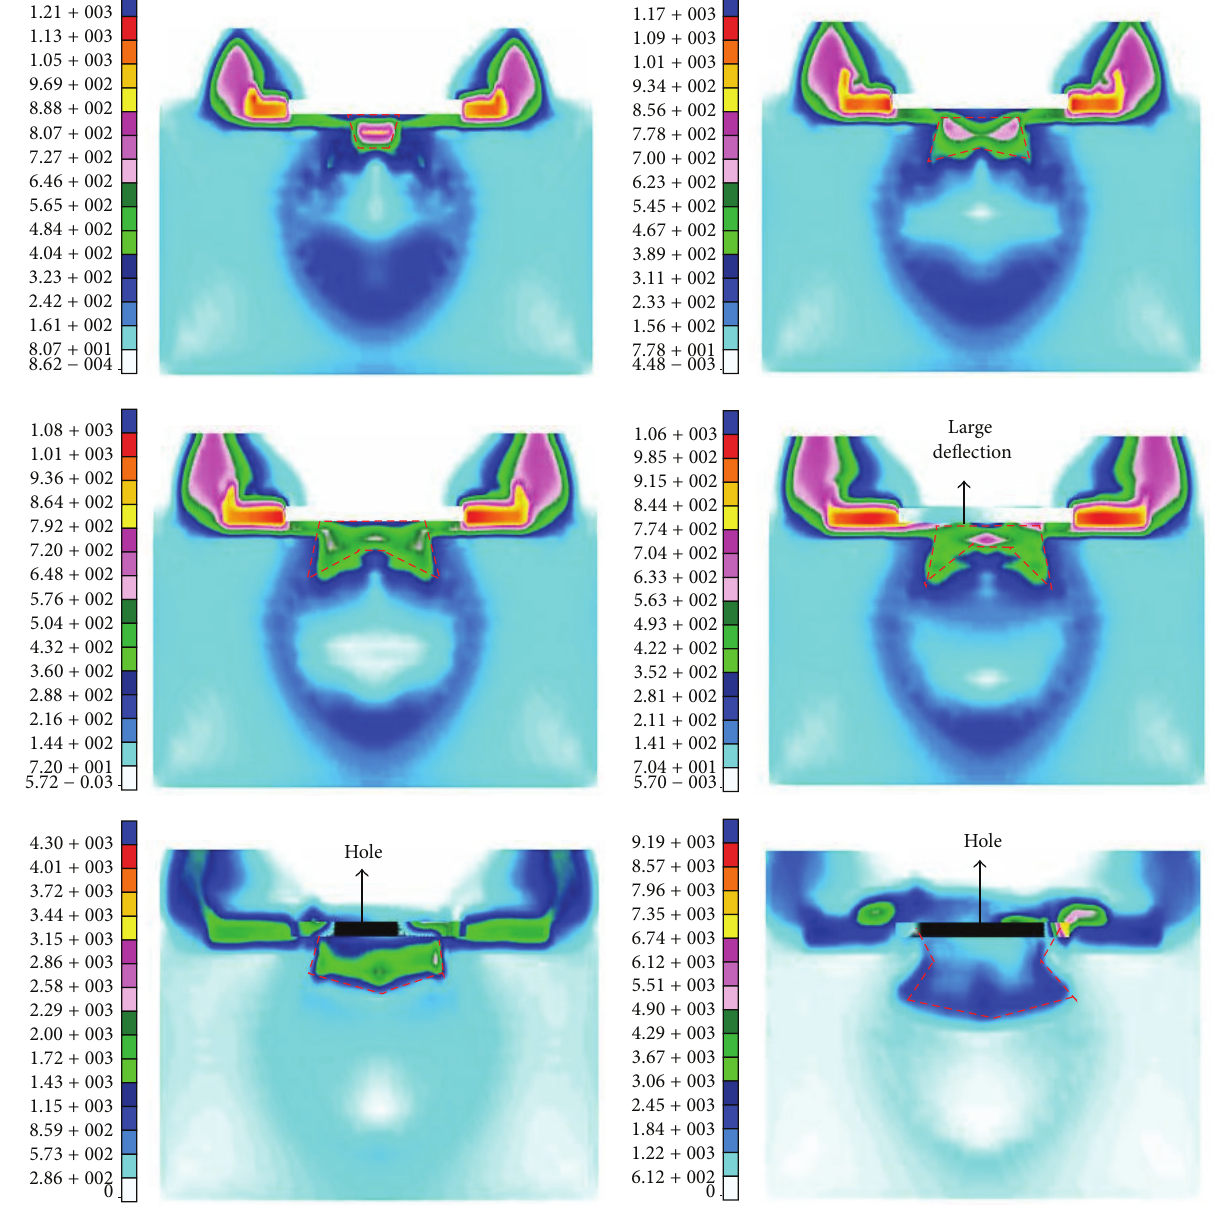
Figure 20: Bubble jet velocity shape at time = 1.0 ms, 1.1ms, 1.2ms, 1.3 ms, 1.4 ms, and 1.5